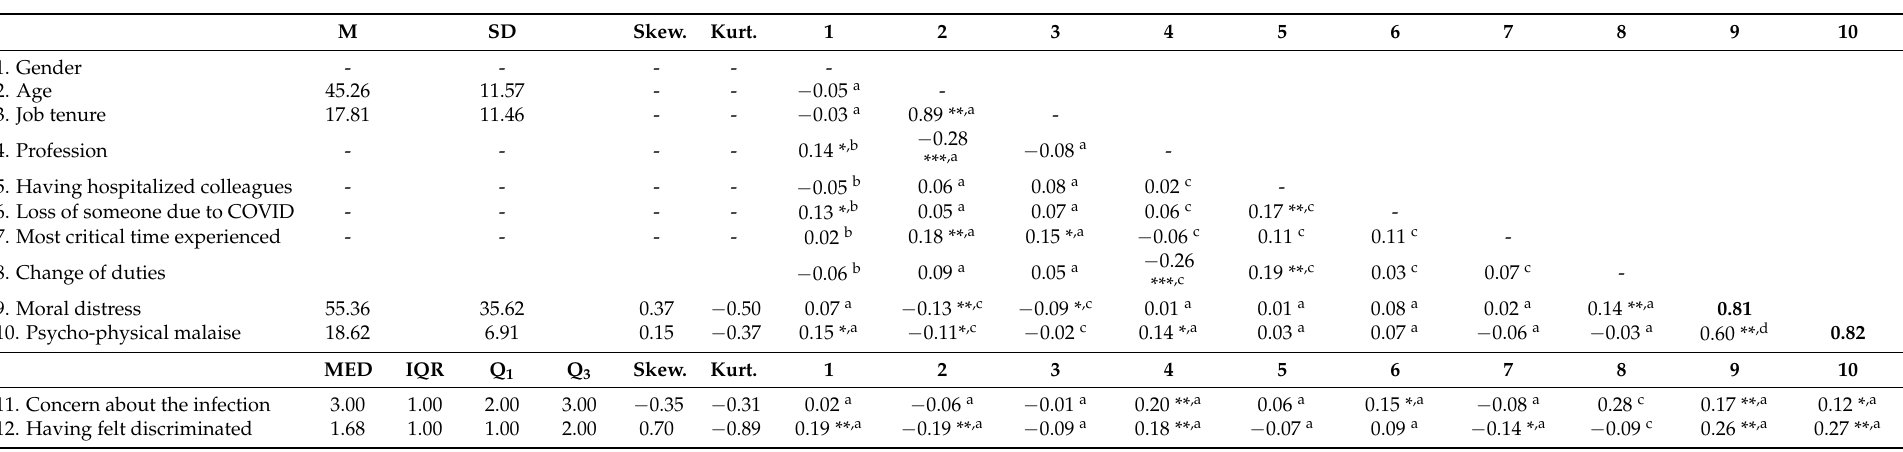
Note. Boldfaced numbers on the diagonal represent Cronbach’s alpha; M = means; SD = standard deviations; Skew. = Skewness; Kurt. = Kurtosis; MED = medians; IQR = interquartile range; Q 1= first quartile or 25th percentile; Q 3 = third quartile or 75th percentile. * p < 0.05; ** p < 0.01; *** p < 0.001; a Spearman’s rho correlation coefficient; b Phi coefficient obtained from contingency table; c Kendall’s coefficient of rank correlation tau-sub-b coefficient, d Pearson’s correlation coefficient. Gender: 0 = men, 1 = women; Age = in years; Job tenure: in years; Profession: 0 = nursing profession, 1 = medical profession; Hospitalized colleagues: 0 = no, 1 = yes; Social stigma: from 1 = never, 4 = often; Loss of someone: 0 = no, 1 = yes; Most critical time: 0 = others, 1 =